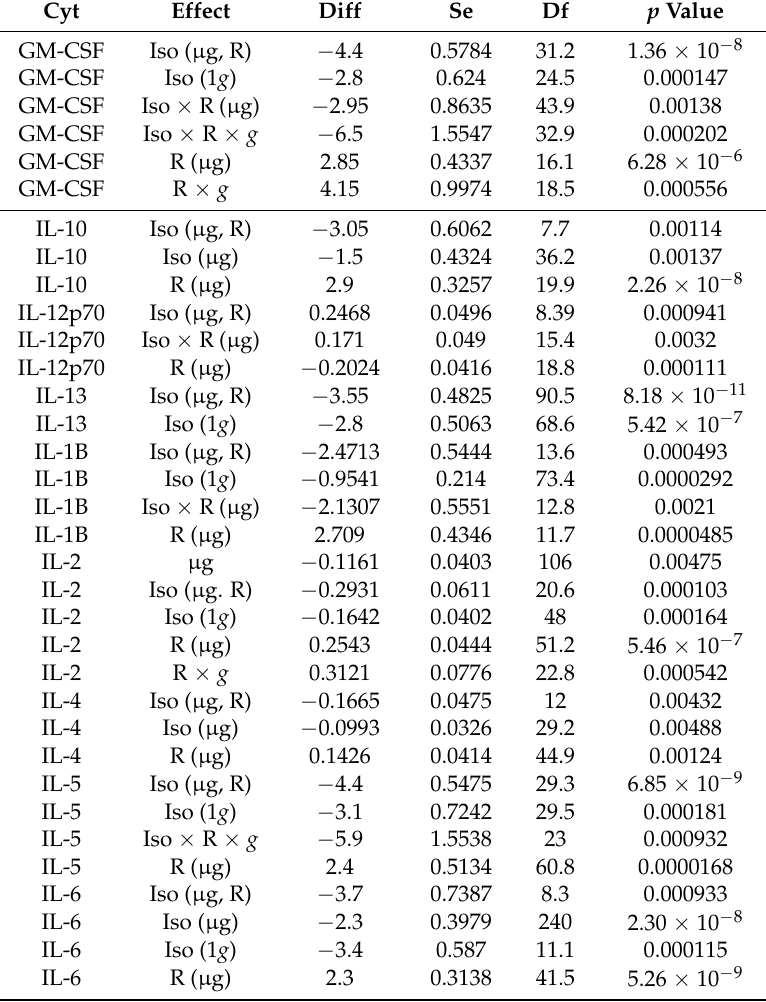
Table 5. Significant differences in mean transformed cytokine concentration (2 Gy). Effects listed below are described in Table